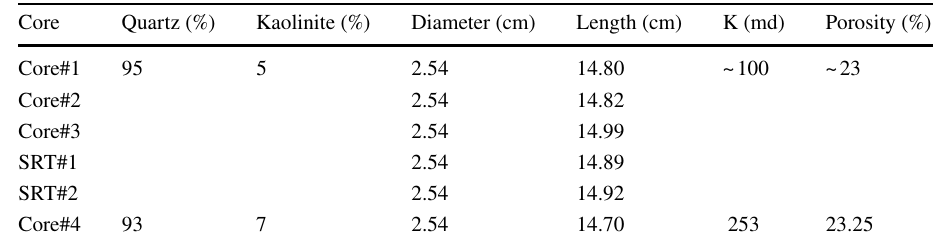
Fig. 1 Schematic diagram of the experimental